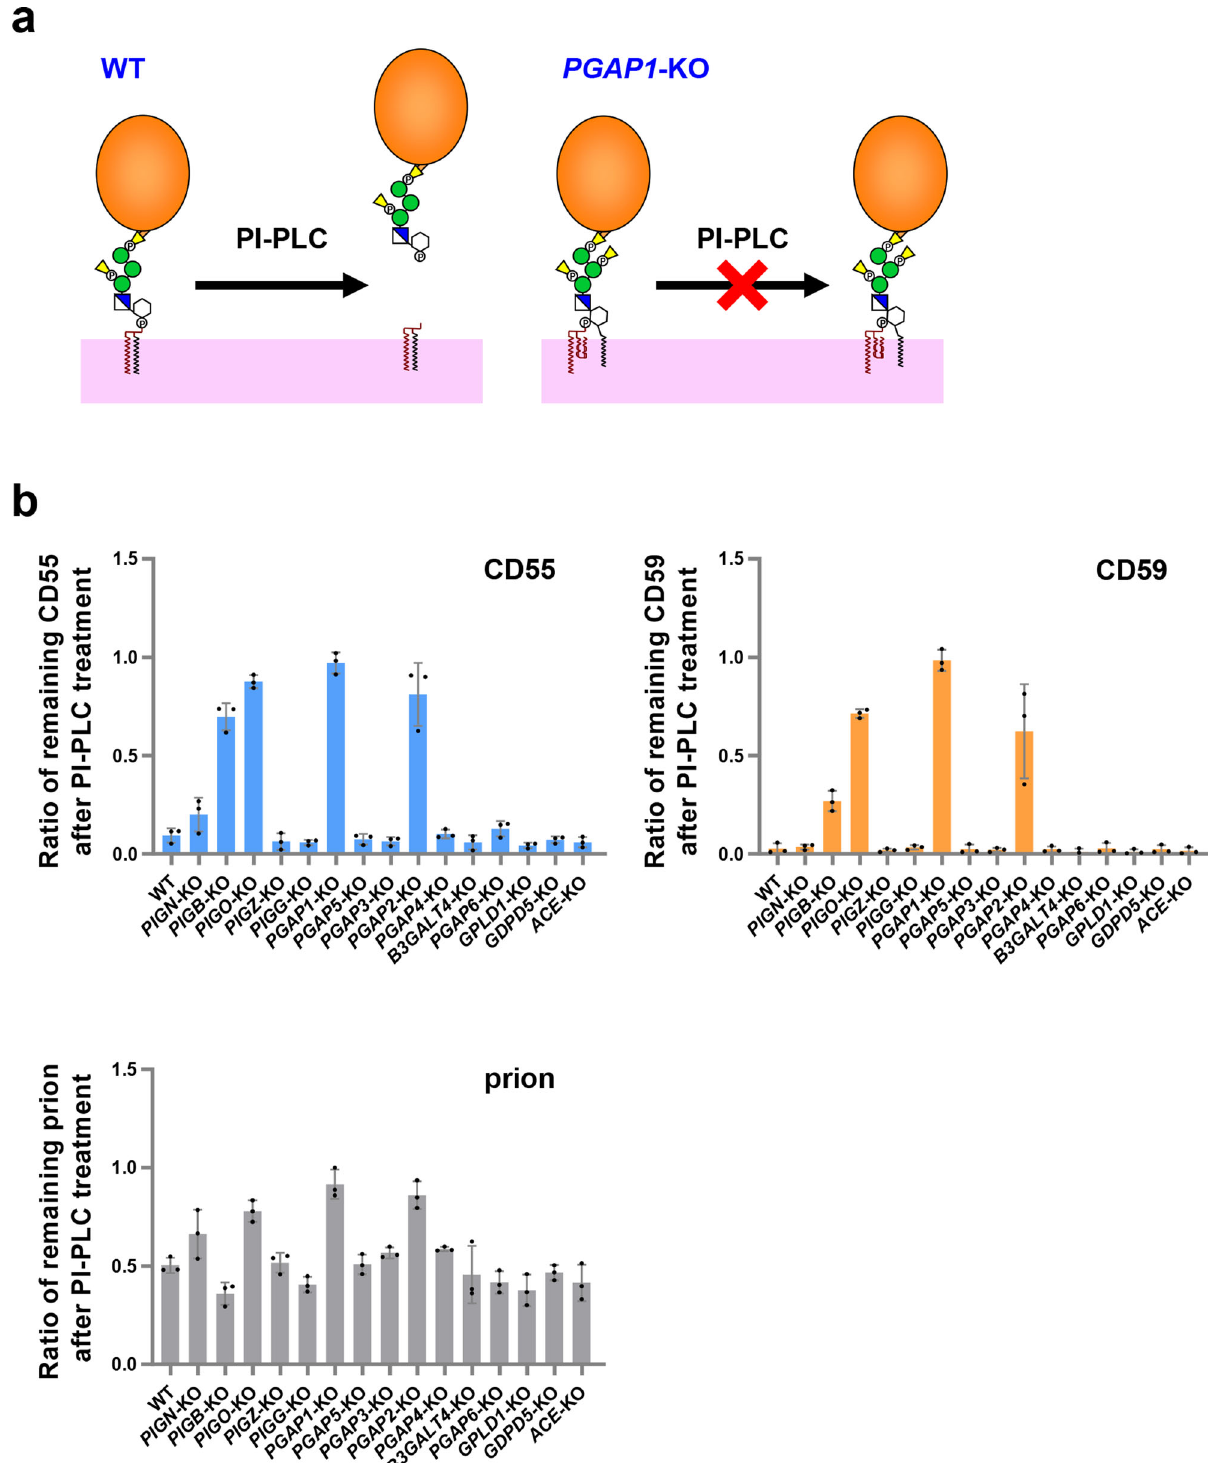
Fig. 3 The PI-PLC catalytic reaction releases GPI-APs on the cell surface. a Schematic representation of PI-PLC activity against GPI-APs. The remodeled mature GPI-APs on the cell surface in WT cells are cleaved by PI-PLC and released from the plasma membrane. On the other hand, the inositol-acylated GPI-APs in PGAP1 -KO cells show resistance to PI-PLC. b PI-PLC sensitivity of CD55, CD59, and prion. WT and KO cell lines were treated with and without PI-PLC. The residual amounts of CD55, CD59, and prion on the cell surface after PL-PLC treatment were analyzed by fl ow cytometry. The ratio of remaining GPI-APs was calculated and is shown as the mean ± SD from three independent